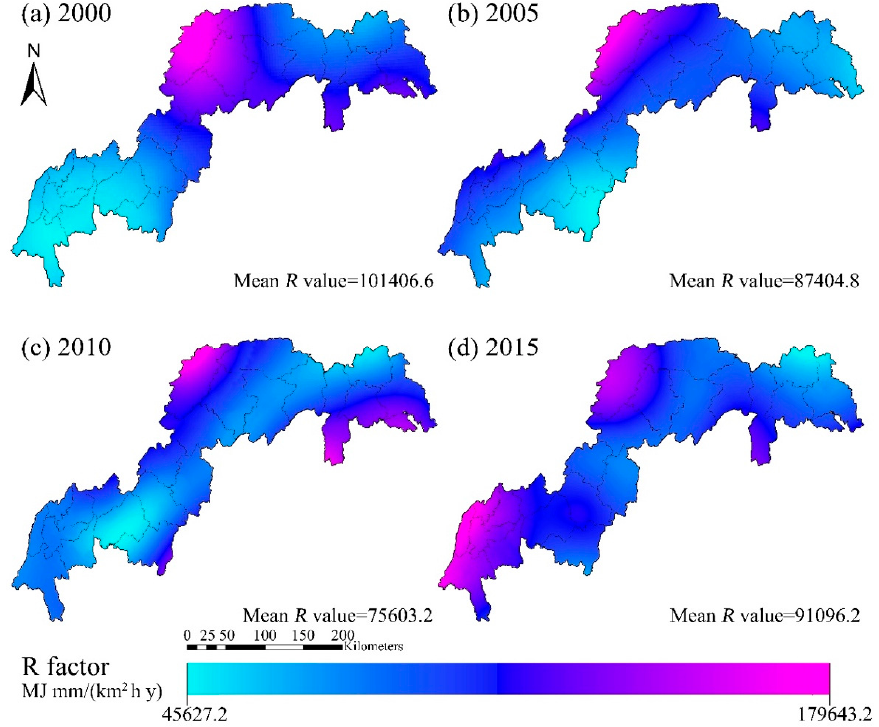
Figure 4. Estimated changes in the spatial pattern of rainfall erosivity, R factor (2000–2015).